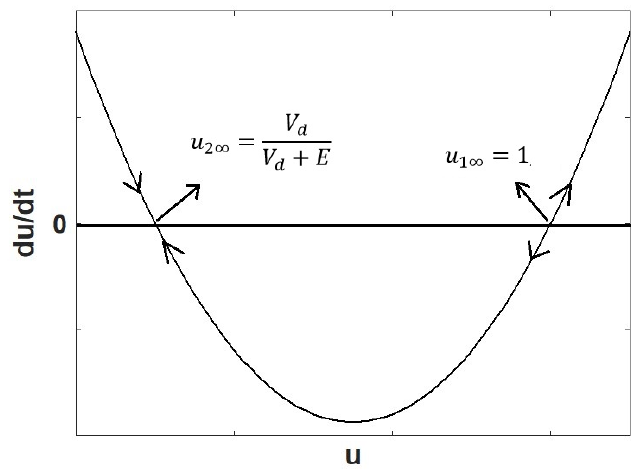
Figure 3. Remaining dynamics of the voltage-controller